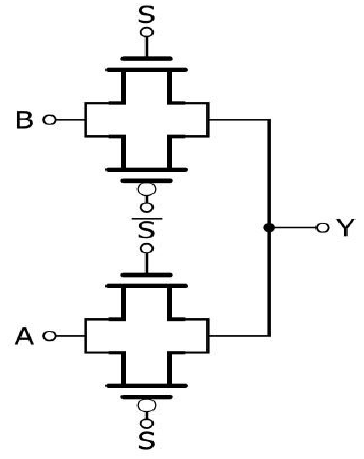
Figure 6. Circuit diagram of gain selection